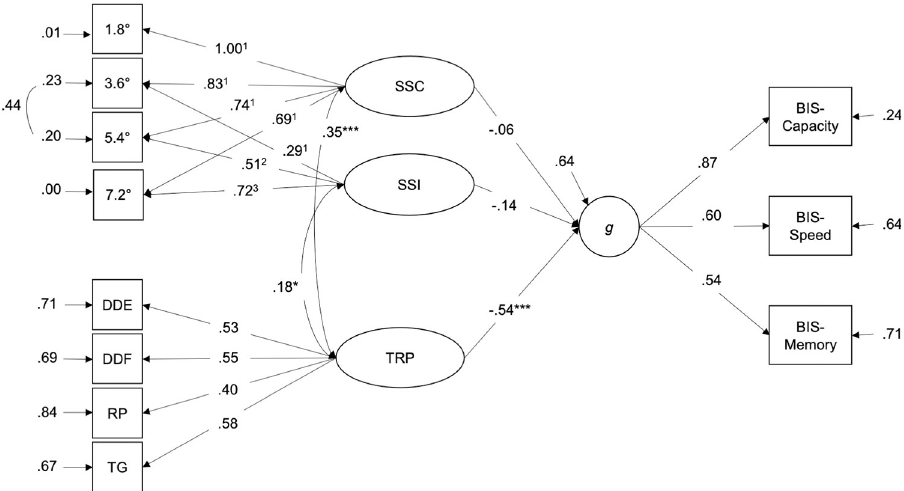
Fig 3. Final model illustrating the interplay between spatial suppression, TRP, and the g factor. Two latent variables were derived from the spatial suppression task, one representing individual differences in spatial suppression (SSI) and the other representing individual differences in motion-direction discrimination thresholds independent of stimulus size (SSC). Standardized factor loadings and regression coefficients are presented and unstandardized factor loadings for the spatial suppression measurement model are given in superscript. N = 273 participants. � p < .05, ��� p <